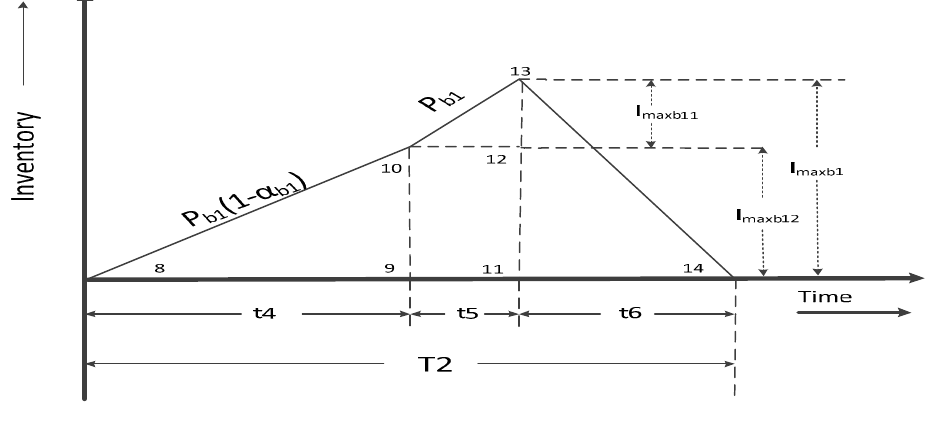
Figure A2. Inventory diagram of 1st outsourcer .